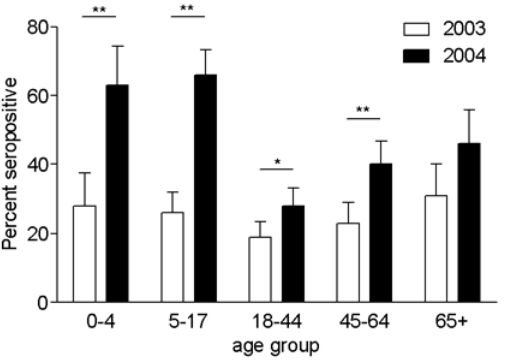
Figure 1. Age-distribution of seroconversion to influenza virus in 2003 and 2004. Charts show the proportion of sera from the summers of 2003 (clear bars) and 2004 (filled bars) that gave a HI titre above 1/40 for each age group against A/Wyoming/3/03 (antigenically equivalent to A/Fujian/411/02), together with the 95% confidence interval (error bars). Asterisks denote statistical significance (*p , 0 ? 05; **p , 0 ? 01). A total of 882 and 799 serum samples were tested for 2003 and2004 respectively, each in duplicate, togetherwith control ferret sera.